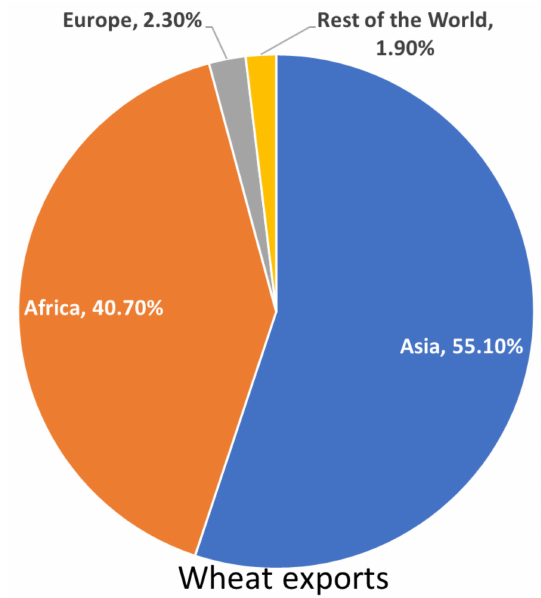
Figure 7. Ukrainian wheat exports by destination in 2021